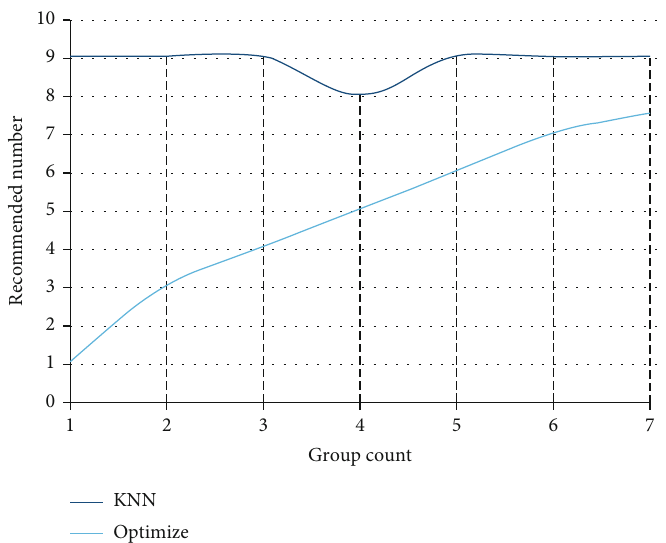
Figure 2: Comparison of the average number of recommendations